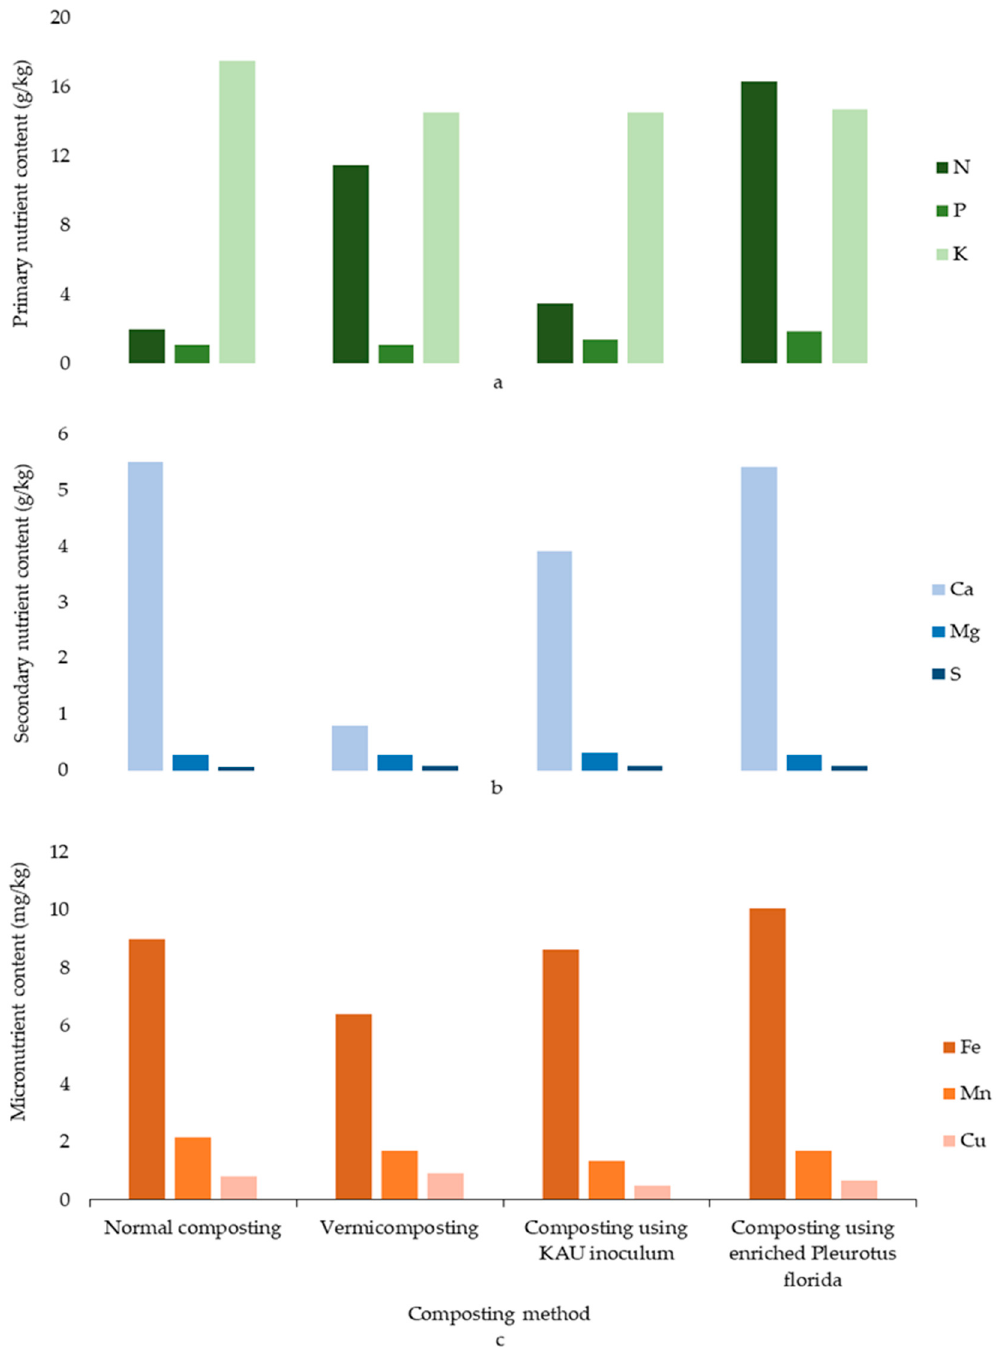
Figure 6. Effect of different composting methods on ( a ) primary, ( b ) secondary, and ( c ) micronutrient content of compost from Limnocharis flava (L.) Buchenau [73].